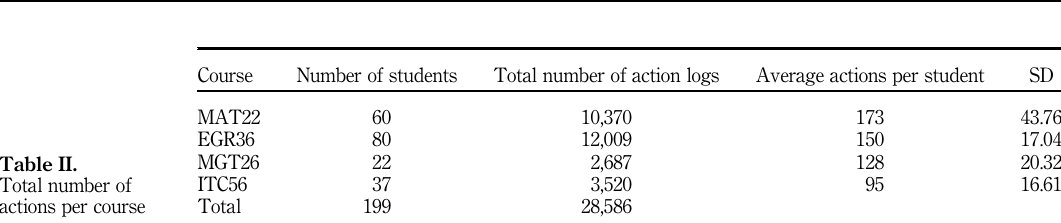
Table I. Moodle action log data attributes